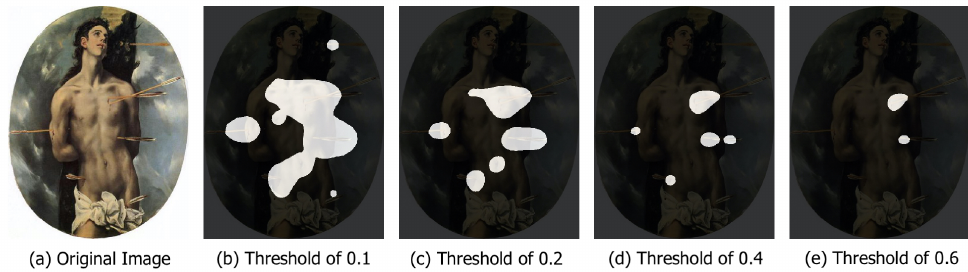
Figure 5. Analysis with different thresholds—black areas correspond to class activation map values below the specified threshold (background) while white pixels correspond to class activation map values greater or equal than the threshold (foreground). An increment in the threshold value results in smaller and more distinct areas. Original image ( a ), cam with threshold at 0.1 ( b ), cam with threshold at 0.2 ( c ), cam with threshold at 0.4 ( d ), cam with threshold at 0.6 ( e